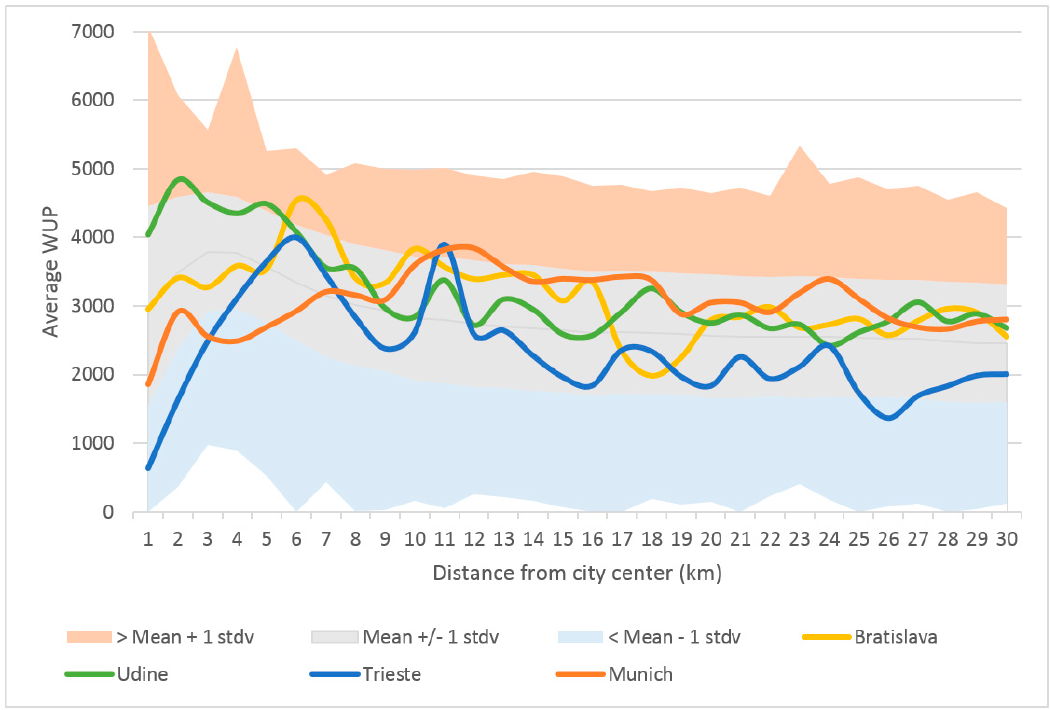
Figure 8. Variations in average WUP per concentric rings across cities using a 2 km horizon of perception. The faint grey line represents the average WUP across all EU cities, the blue area represents zones with average WUP values inferior to the mean by more than one standard deviation, and the area in red represents zones with average WUP values superior to the mean by more than the standard deviation.